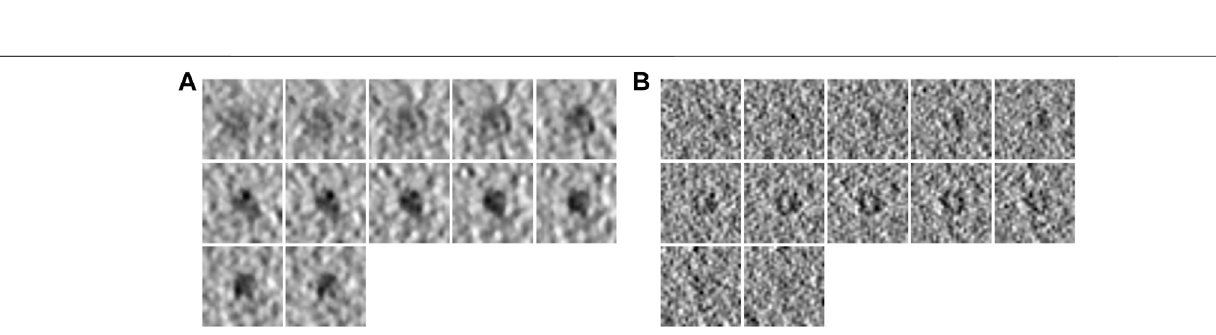
FIGURE3| Densitymapandmolecularweight(kDa)ofeachPDBIDinSHRECdata.ThetoprowisthePDBID.Thebottomrowisthemolecularweight(kDa).From left to right, the molecular weight of PDB decreases.